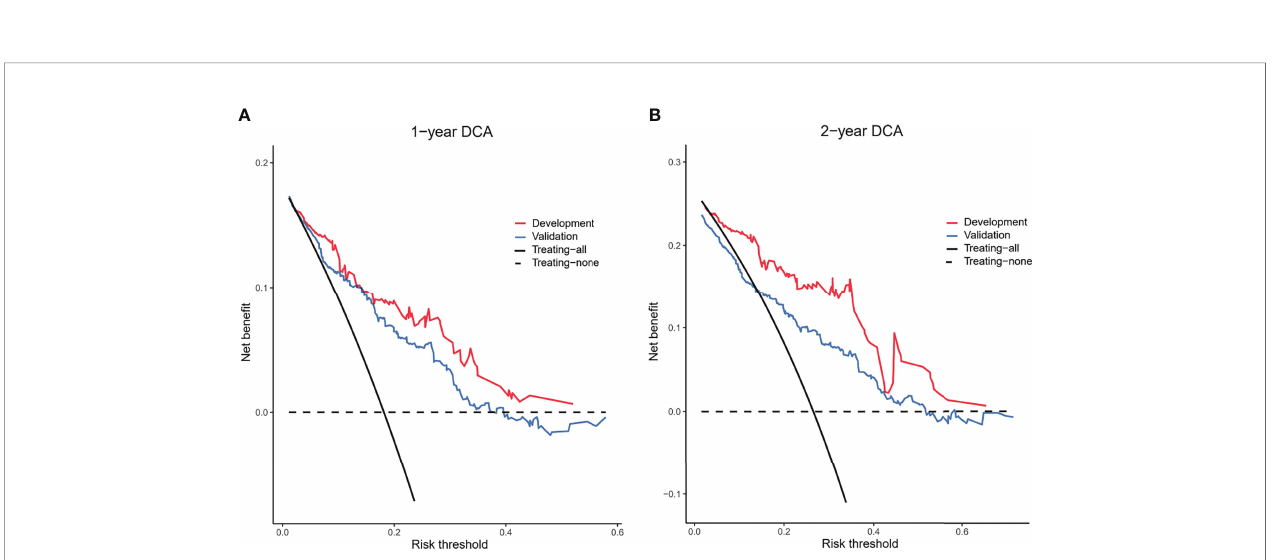
FIGURE 5 | Decision curves of the nomogram model.In the fi gure, the abscissa is the threshold probability, and the ordinate is the net bene fi t rate. The horizontal image indicates net bene fi t when all patients with OMG are considered have not developing generalization and not treated. The oblique image indicates net bene fi t when all patients with OMG are considered having develop generalization and treated. (A, B) depict the decision curves predicting the 1- and 2-year generalization probabilities in the development and validation cohorts,